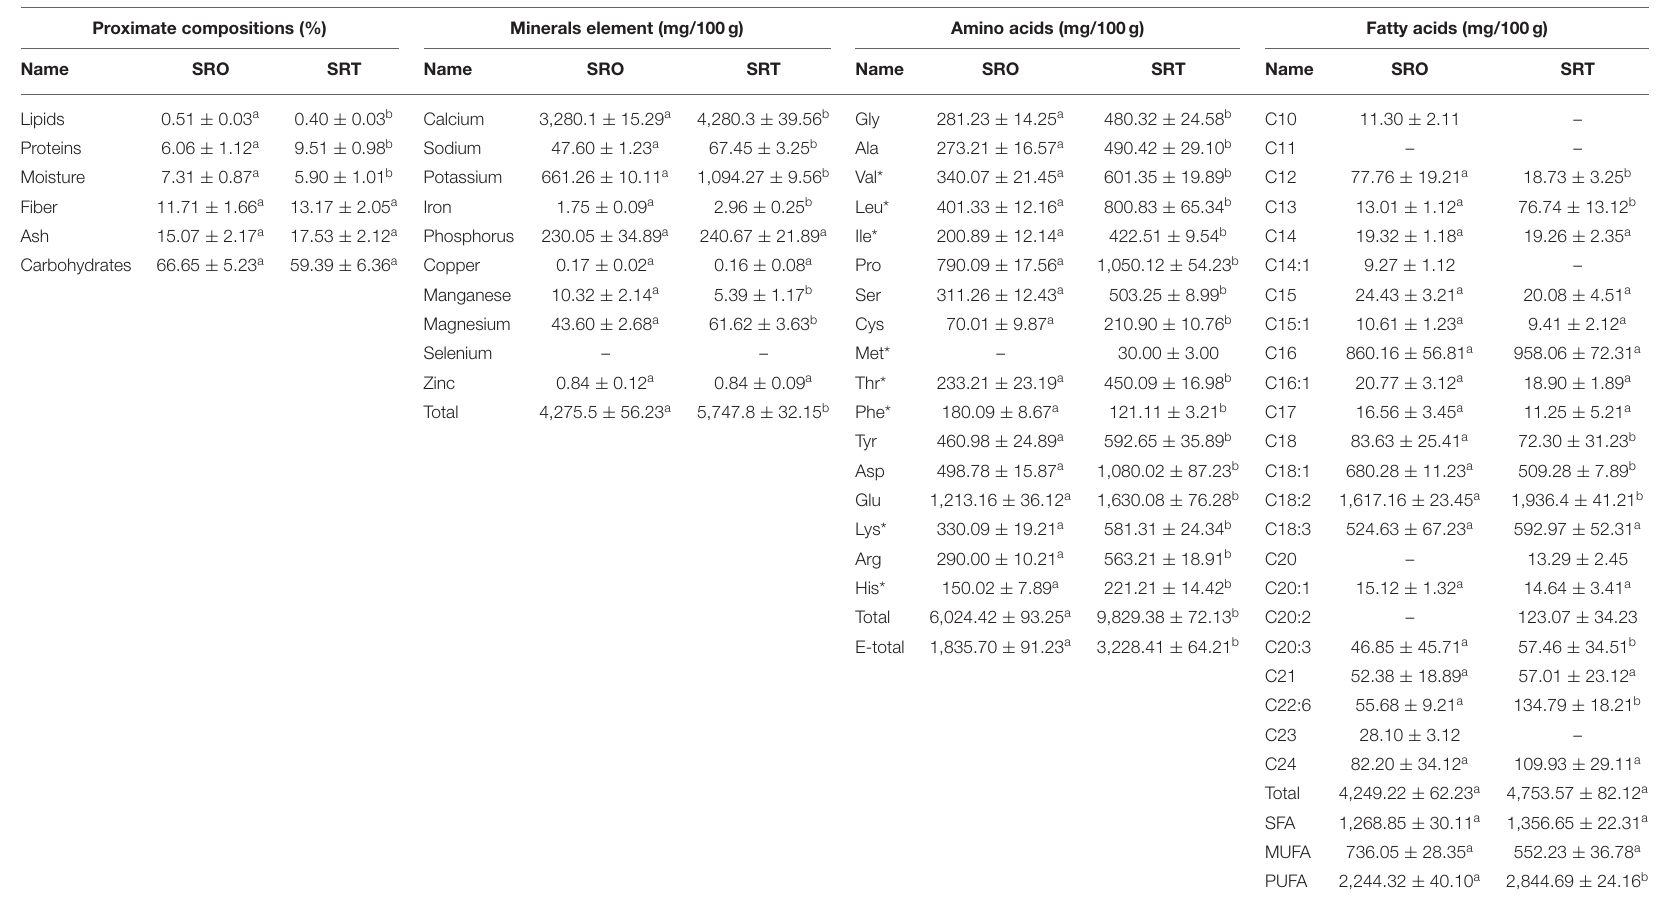
SFA, saturated fatty acids; MUFA, monounsaturated fatty acids; PUFA, polyunsaturated fatty acids; E-total, The total contents of eight essential proteins and one protein (His) for children. Different letters denote of data significant difference at p < 0.05 between the two group and those followed by same letters denote no significant